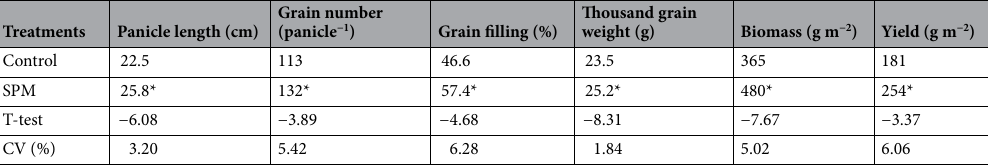
Table 6. Effect of spermine on panicle length, grain number, grain filling, thousand grain weight, biomass and yield in KADA. T-test was performed at P ≤ 0.05. *: Significant at P ≤ 0.05. KADA: Kemubu Agricultural Development Authority. CV: Coefficient of variation.